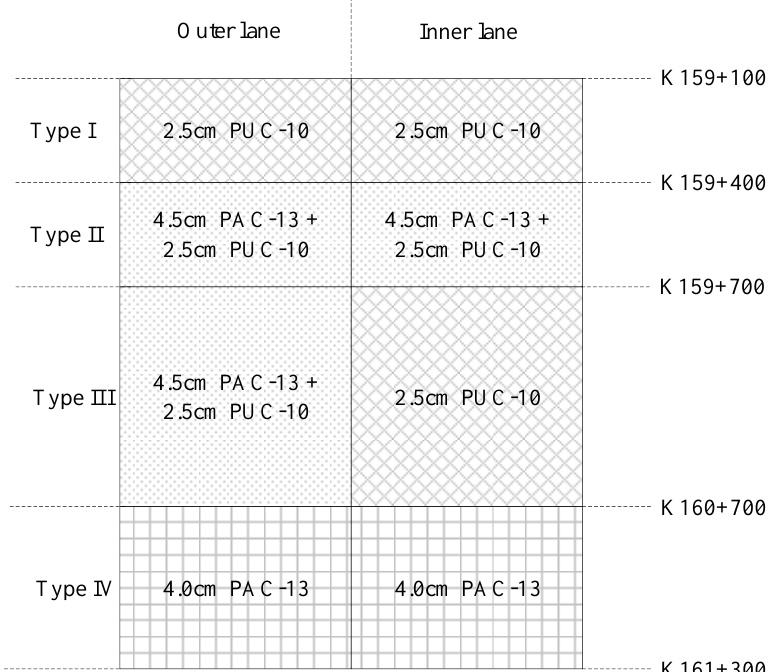
Figure 1. Combinations of pavement structures for the experimental Figure 1: Combinations of pavement structures for the experimental section.